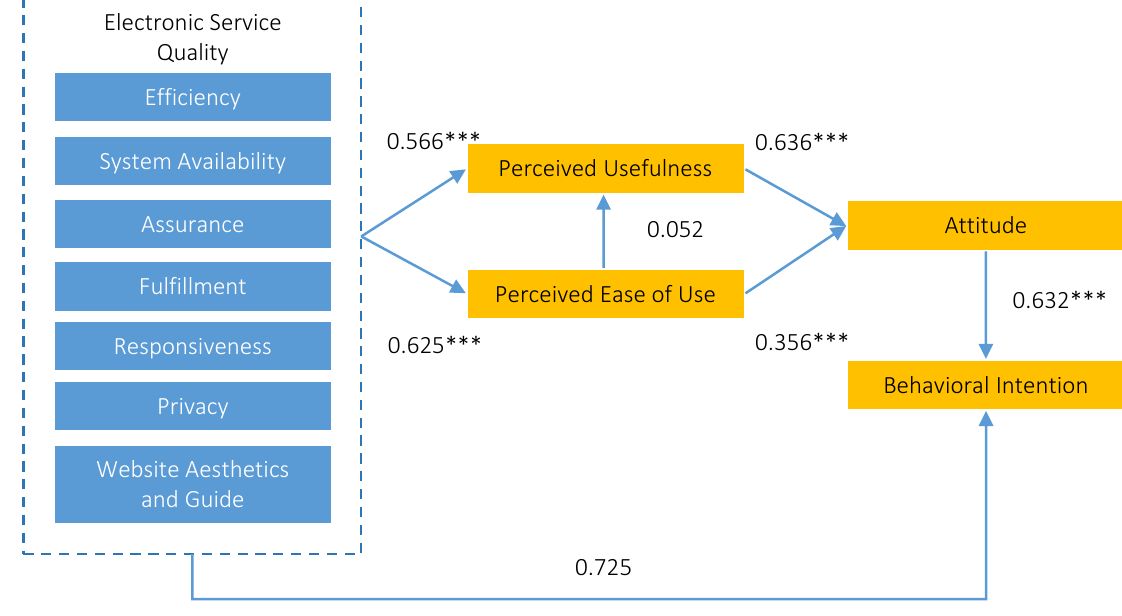
Figure 3. Results of structural model testing